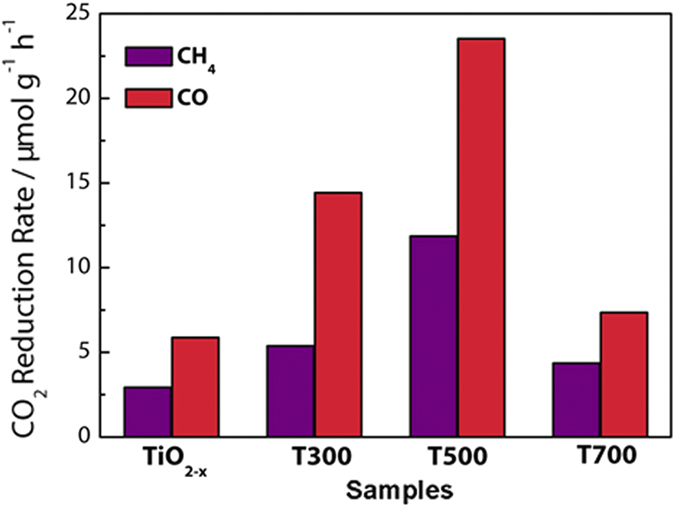
CO2 reduction rate of the brookite TiO2−x, T300, T500 and T700 samples.